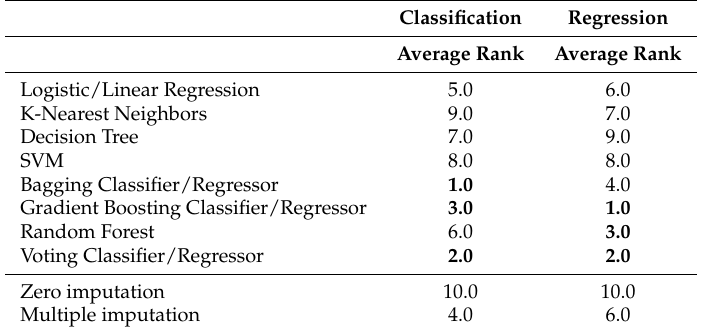
Table 14. Overall ranking of classification and regression models for different feature sets.